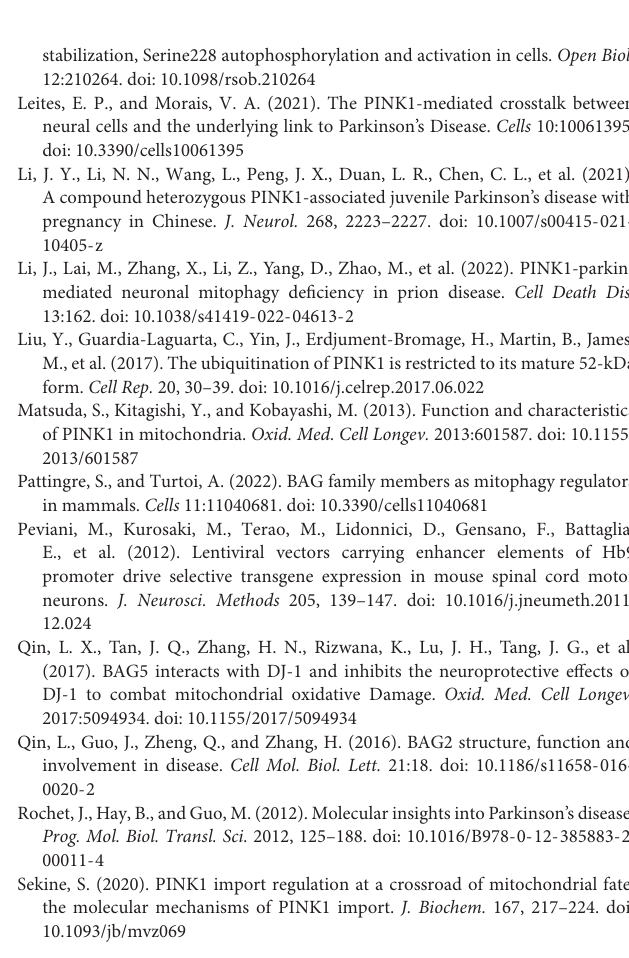
Supplementary Figure 1 | Expression of C-terminal and N-terminal HA tagged PINK1 R492X . The HA tag was added to the C-terminal (A) or N-terminal (B) PINK1 R492X , the expression was confirmed by